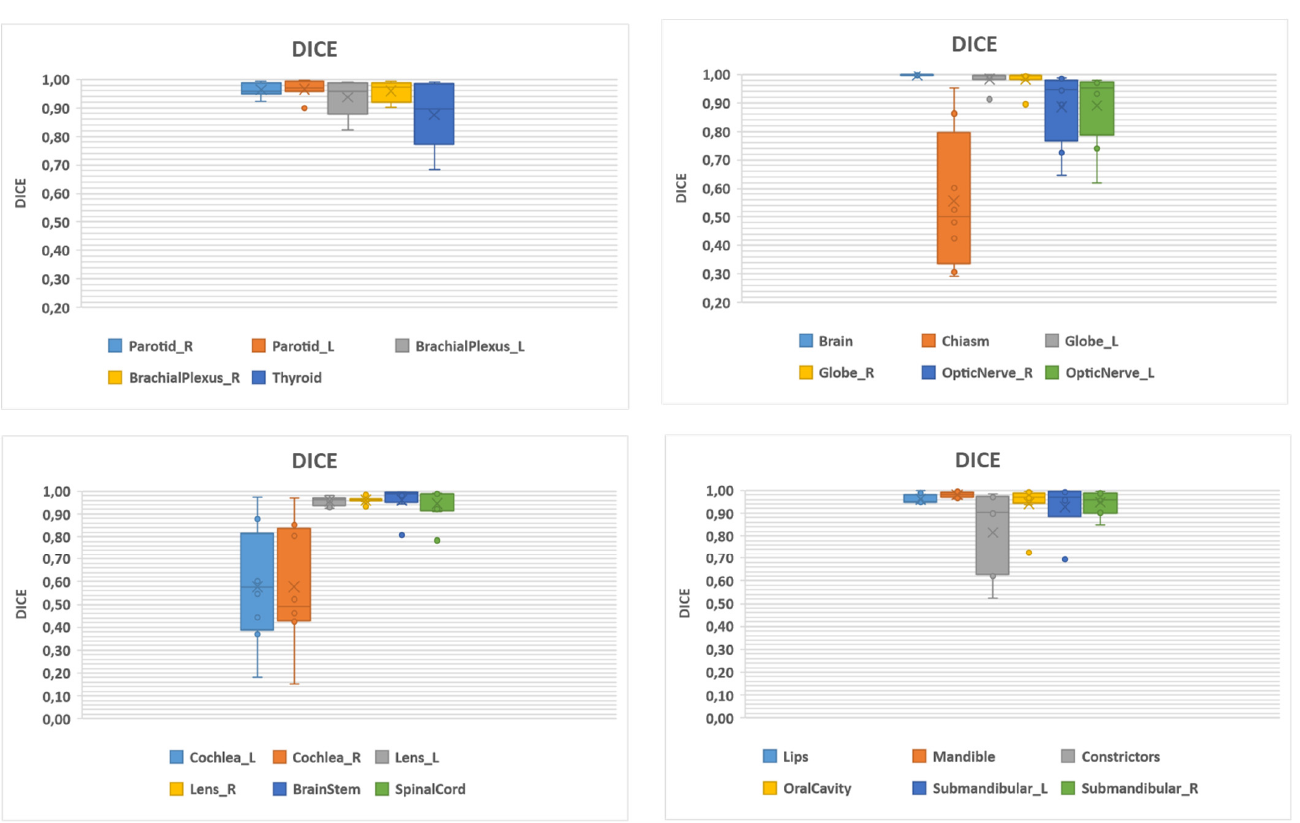
Figure 1. Boxplot analysis of DICE.